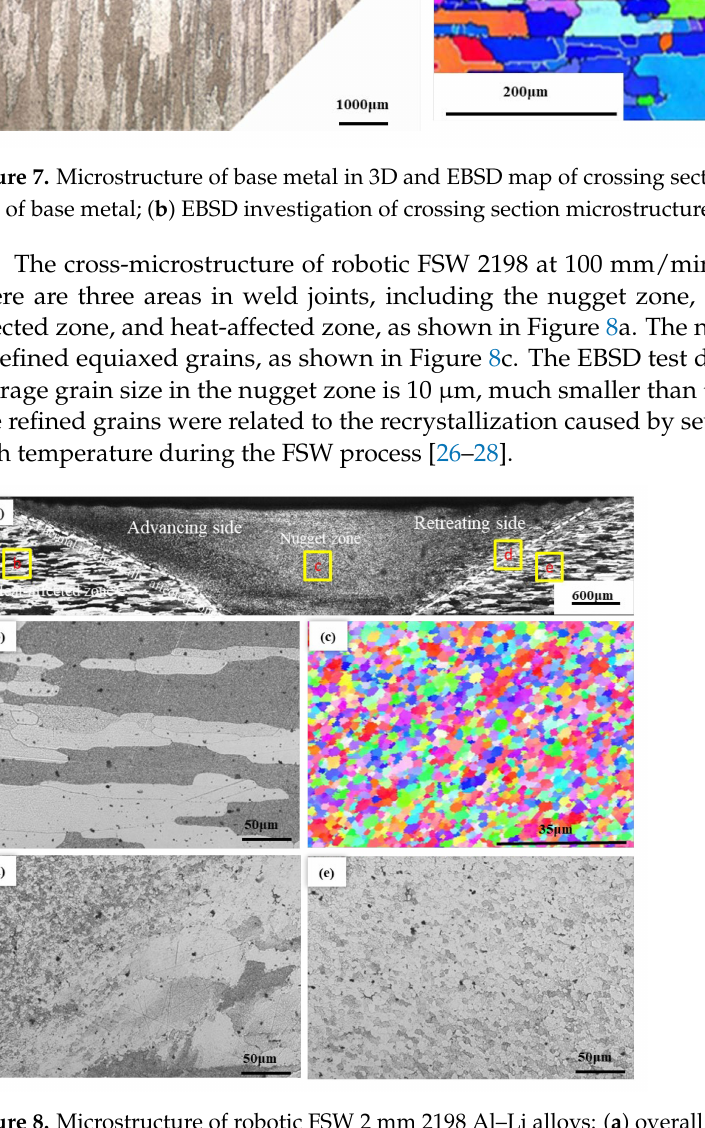
Figure 8. Microstructure of robotic FSW 2 mm 2198 Al–Li alloys: ( a ) overall microstructure; ( b ) base metal; ( c ) nugget zone; ( d ) thermo-mechanically affected zone; ( e ) heat affected zone. The grain size in the nugget zone depended on strain rate and deformation tem- perature. These two variables can be expressed by the Zener–Hollomon parameter (Z) as